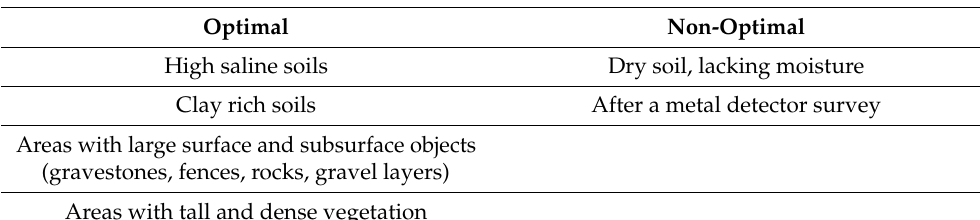
Table 4. Compiled list of the optimal and non-optimal areas in which to conduct a resistivity survey as per Moffat [5] and Pringle et al.